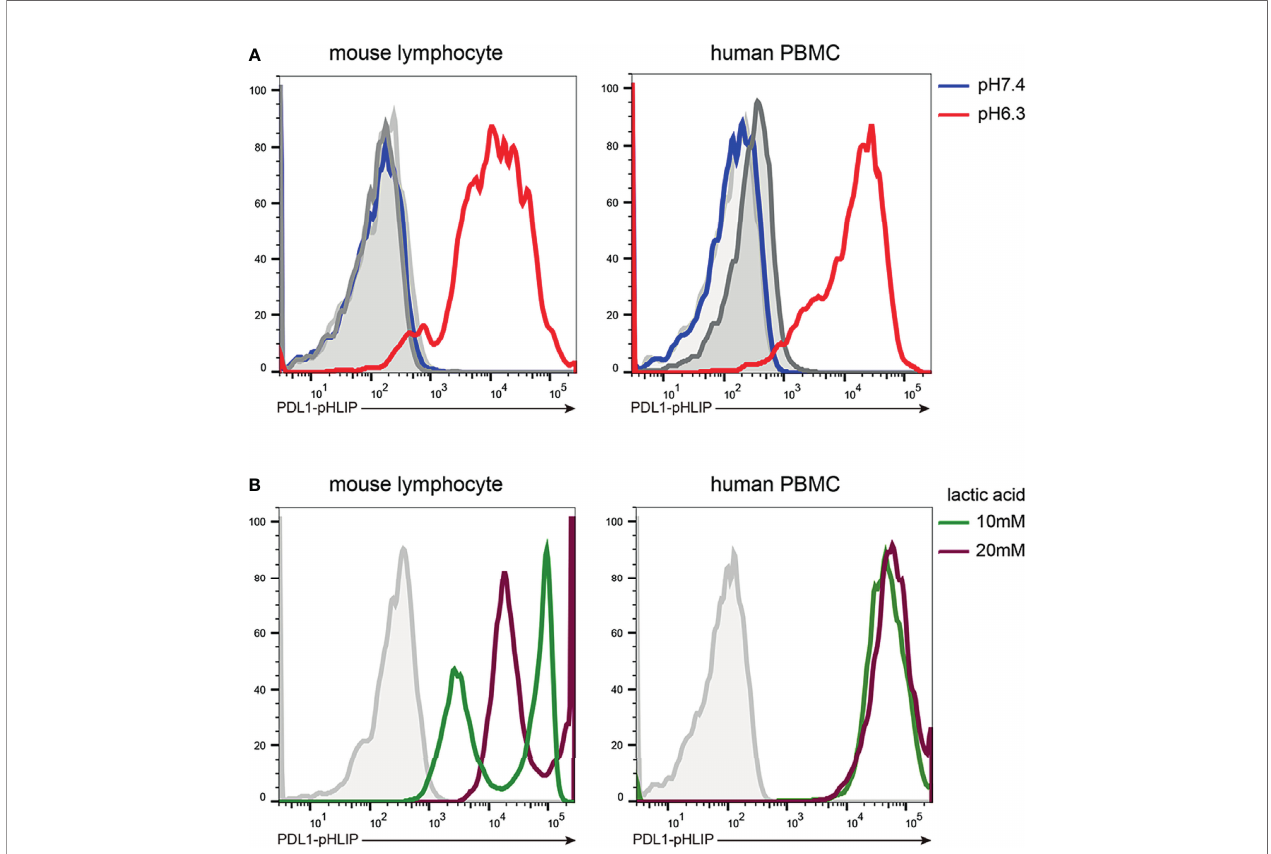
FIGURE 3 | The low pH-responding ability of PD-L1-pHLIP to insert into primary murine and human lymphocytes. Mouse lymphocytes and human PBMC were isolated from the spleen of Balb/c strain and heathy volunteers, respectively. PE-conjugated PD-L1-pHLIP (10 m g/ml) were incubated with these cell populations for 1 h in pH 7.4 or 6.3 buffer (A) or buffer containing 10 or 20 mM lactic acid (B) . The fl uorescence was examined by fl ow cytometry. Representative plots from three independent experiments were